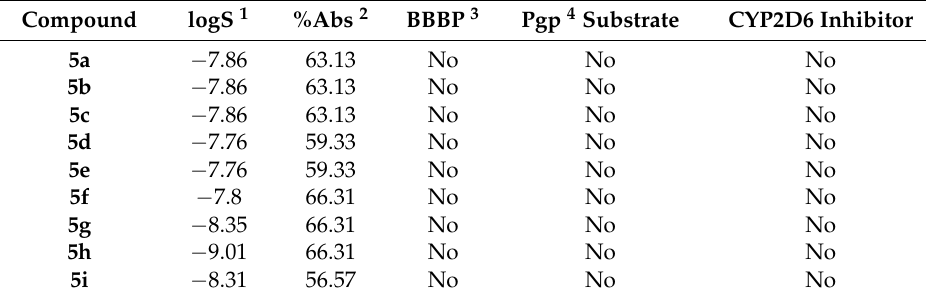
Table 5. In silico pharmacokinetic properties of compounds 5a – i